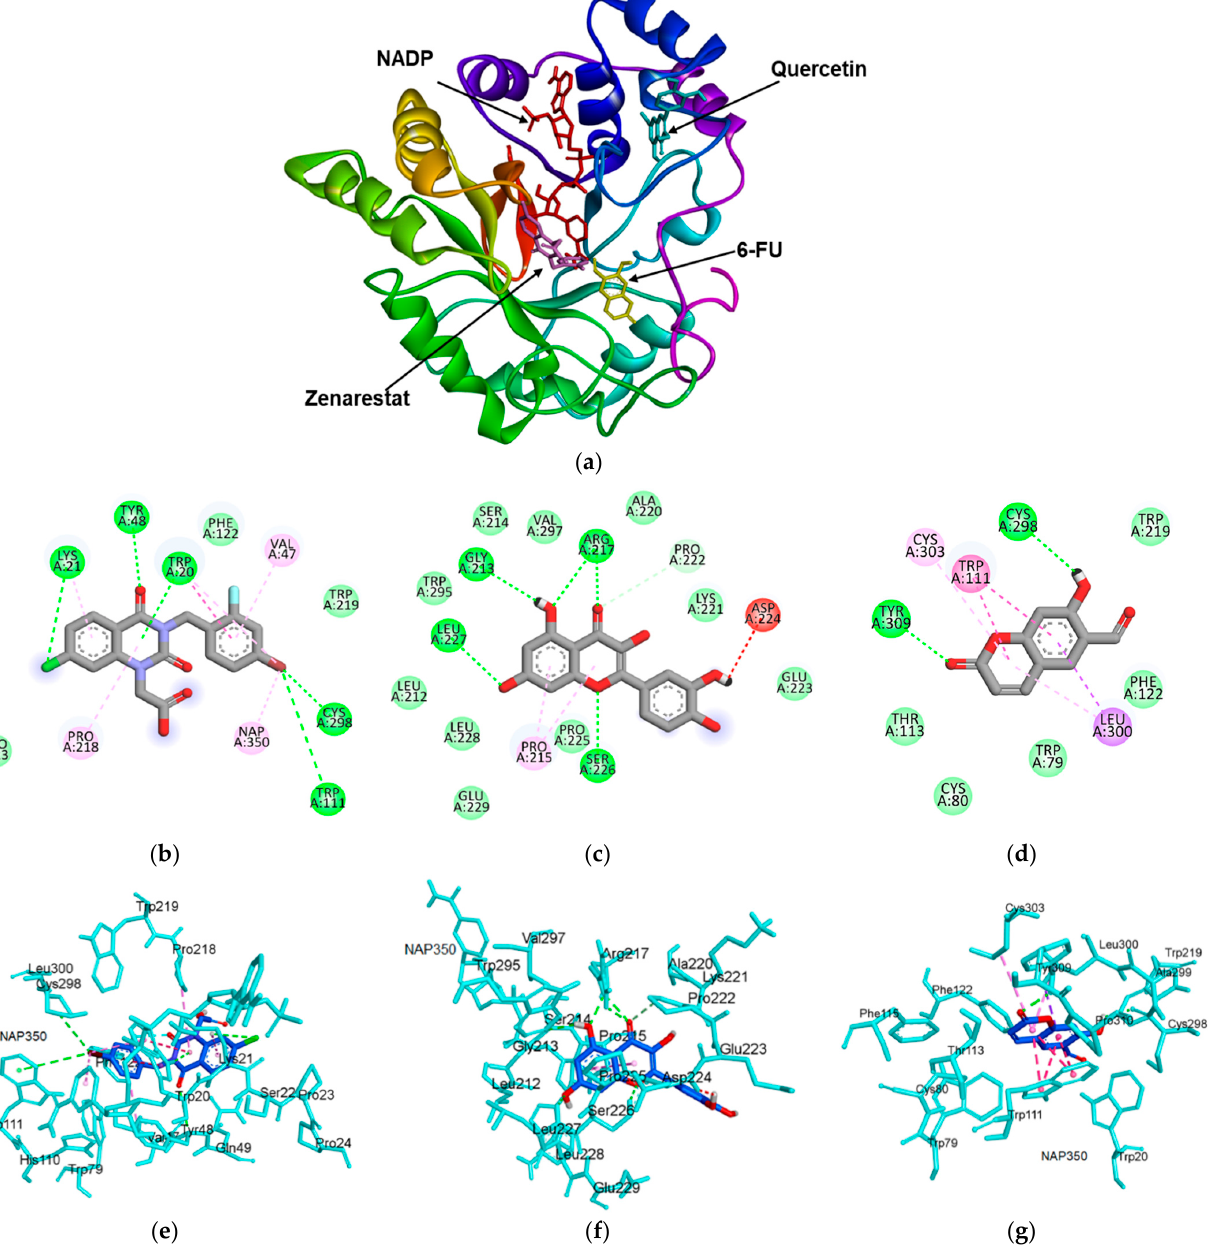
Figure 4. Molecular docking model for human recombinant aldose reductase (HRAR) inhibition by 6-formyl umbelliferone (6-FU). ( a ) Overlapping of the docked 6-FU (yellow), zenarestat (dark pink), NADP (red), and quercetin (cyan) within the active site of HRAR (PDB: 1IEI). 2D interactions of zenarestat ( b ), quercetin ( c ), and 6-FU ( d ) inside the active pocket of HRAR. Molecular docking model for HRAR inhibition by 6-FU and diagrams of 3D ligand interactions and major binding interactions between the inhibitors and the active site of 1IEI: zenarestat ( e ), quercetin ( f ), and 6-FU ( g ). The interactions are represented in green (conventional hydrogen bonding), pink ( π -alkyl interactions), purple ( π -sigma), dark pink ( π - π T shaped), and red (donor-donor acceptor). 2.6. Molecular Docking Analysis of 6-FU Interactions with HAS